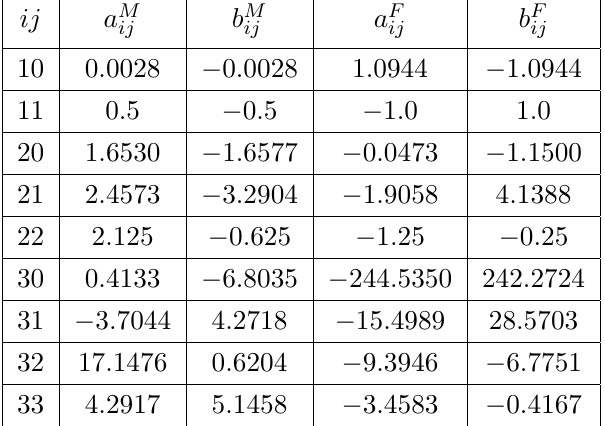
Table 1. Numerical values of the a M;F